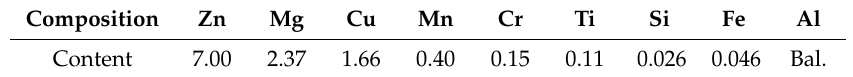
Table 1. Chemical compositions of the studied Al-Zn-Mg-Cu alloy (in wt %). Composition